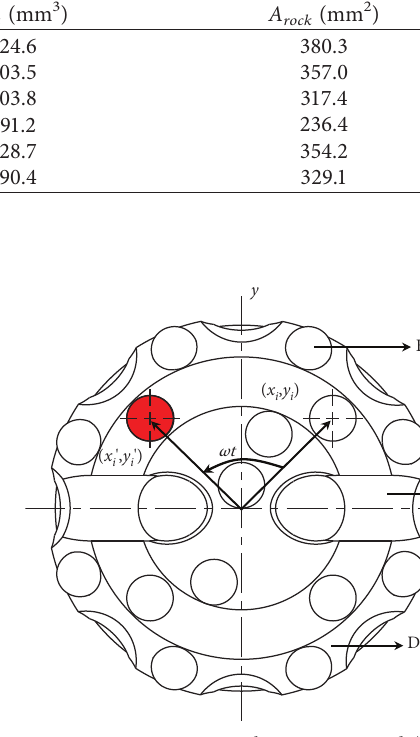
Figure 10: Button position with rotation speed ( ω ) and impact time